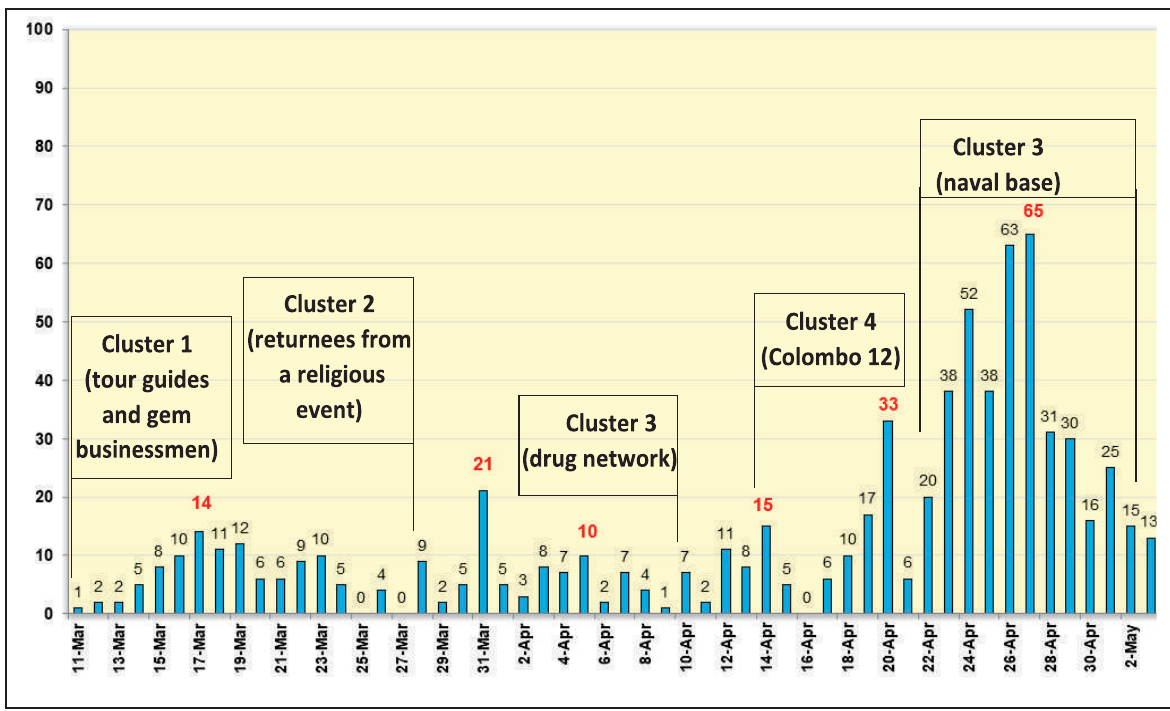
Figure 5: COVID-19 cases reported in Sri